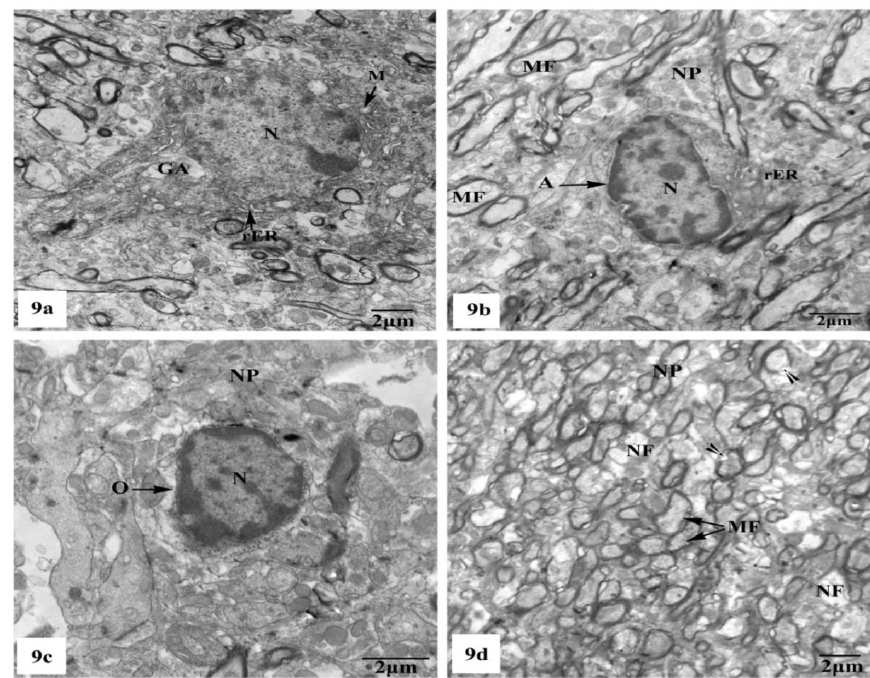
Figure 9. Electron micrographs of the hippocampal CA1 subfields of AlCl 3 + SM-treated rats showing ( a ) nearly normal pyramidal nerve cell which possesses irregular nucleus (N) with dispersed chromatin and the cytoplasm containing less electron-dense mitochondria (M), rER, and Golgi apparatus (GA); ( b ) an astrocyte (A) with nearly normal electron-dense nucleus (N) and cytoplasm having few cristae of rER. The neuropil (NP) with myelinated nerve fibers (MF) is seen; ( c ) an oligodendrocyte (O) with nearly normal cytoplasm and nucleus (N); ( d ) a part of the neuropil (NP) with nearly normal myelinated (MF) and non-myelinated (NF) nerve fibers. Other myelinated nerve fibers appeared with discontinuous and split abnormal myelin sheaths (arrow heads).